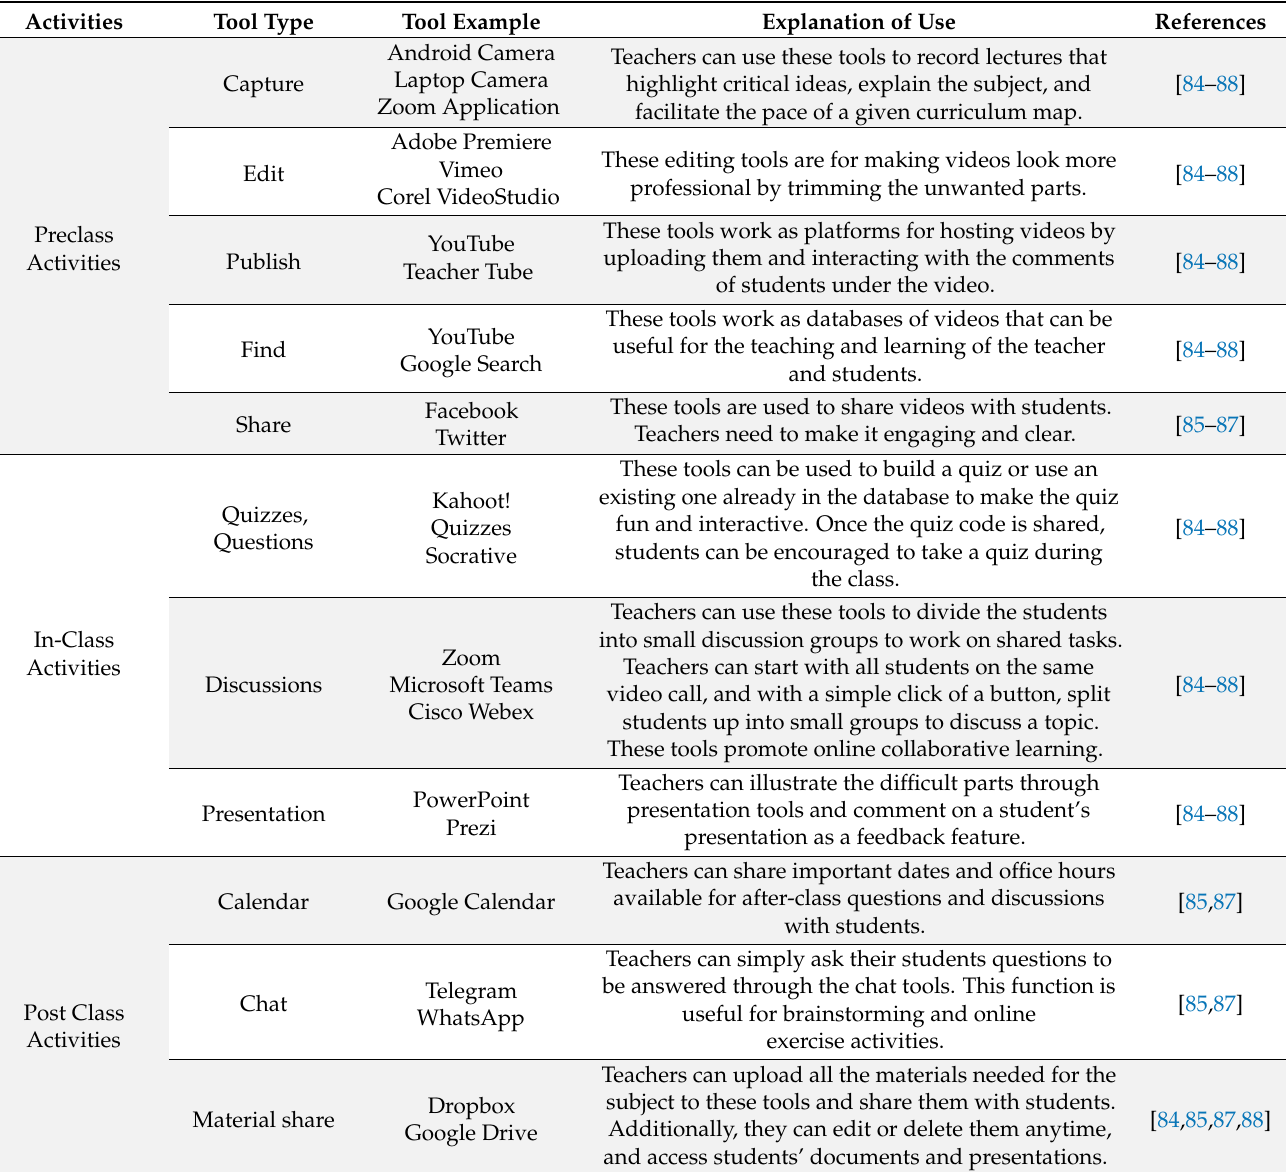
Table 3. PTE guide for flipped